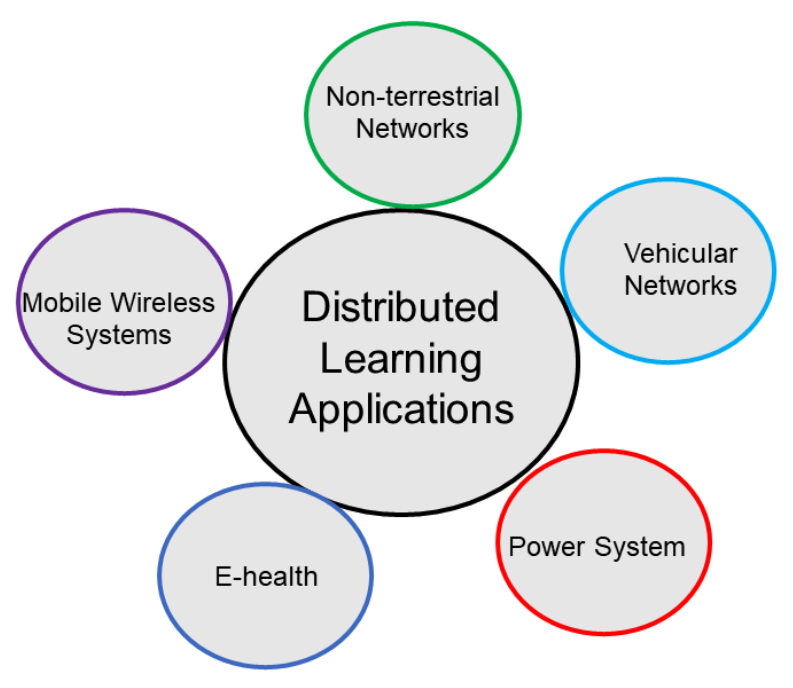
Figure 5. Main applications of distributed